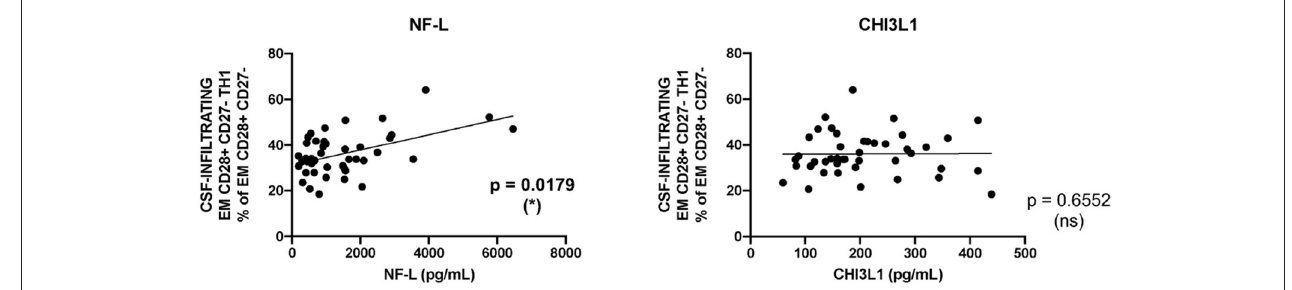
FIGURE 4 | Correlation between CD28 + CD27- EM CD4 + Th1 cells and markers of tissue damage. Correlation between the frequencies of CSF-infiltrating CD28 + CD27- EM CD4 + Th1 cells from patients with MS and the intrathecal amounts of NF-L (left graph) and CHI3L1 (right graph). Each dot in the graphs corresponds to a single patient. Linear correlation between variables was tested using Pearson’s correlation coefficient. Statistical significance (* p < 0.05) is shown.